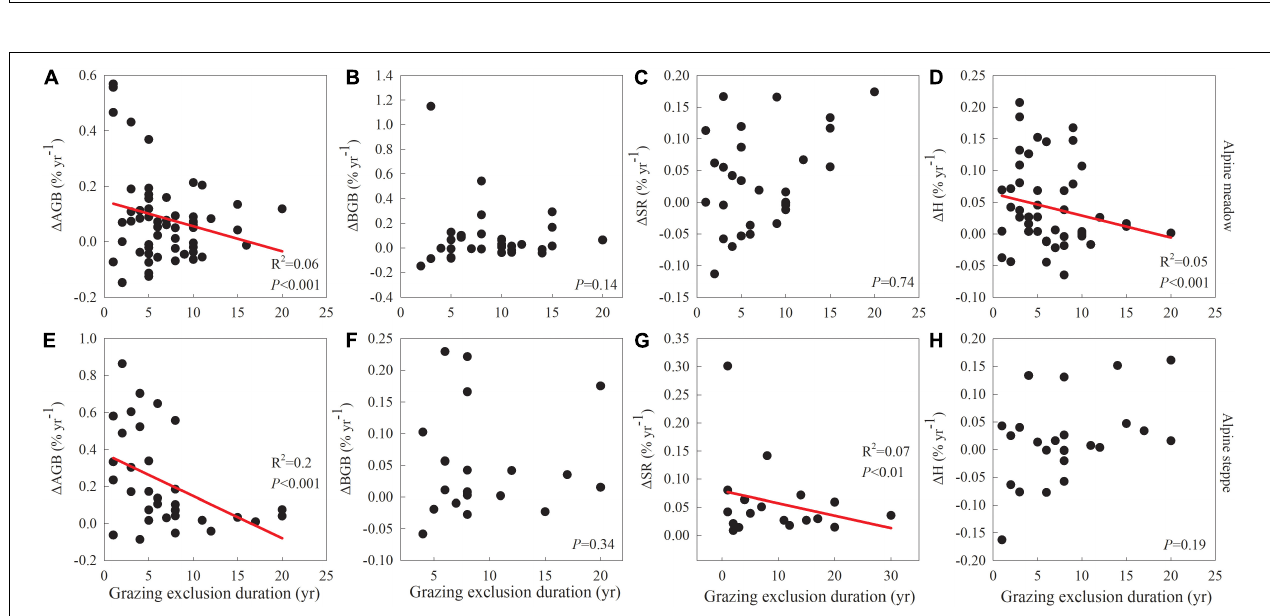
FIGURE 2 | Response ratios (RR) of plant above- and belowground biomass, species richness, and Shannon-Wiener index in response to different grazing exclusion duration in alpine meadows (A–C) and alpine steppes (D–F) . Grazing exclusion durations were divided into short- [1–4 years; (A,D) ], medium- [5–8 years; (B,E) ], and long-term [ > 8 years; (C,F) ], respectively. Error bars are the 95% bootstrapped confidence intervals. AGB, BGB, SR and H represent aboveground biomass, belowground biomass, species richness and Shannon-Wiener index, respectively.